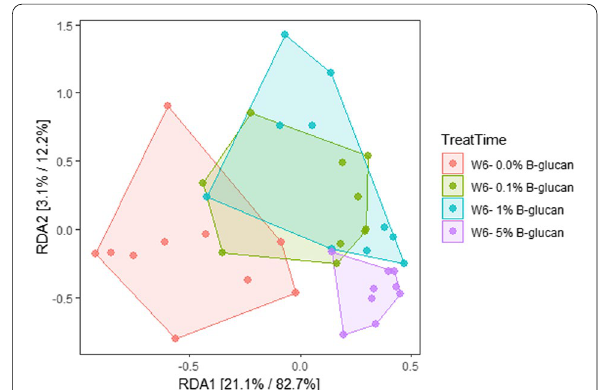
Fig. 3 Redundancy analysis plot illustrating the composition of the microbiota in the intestine of the fish at week 6, constrained based on the concentration of β‑glucan in the diet. Percentages in the axis indicate the percentage of the total variation explained by the treatment group; followed by the effect of this axis on the total variation between